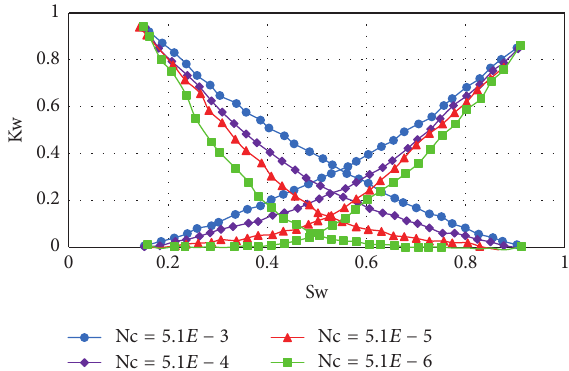
Figure 2: Capillary number affected relative permeability